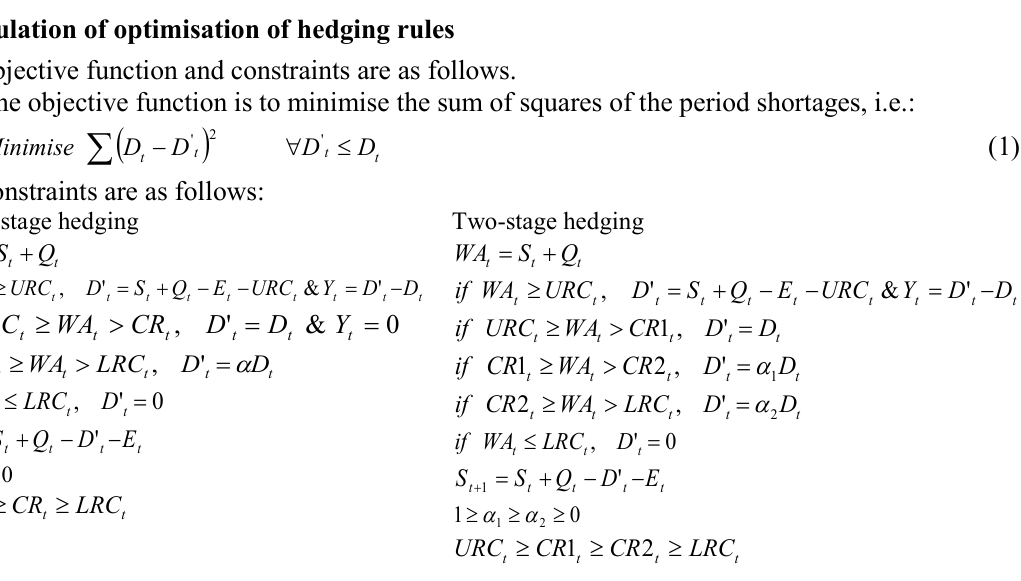
Fig. 1 Schematic illustration of hedging rules showing (a) no-hedging (b) single-stage hedging and (c) two-stage